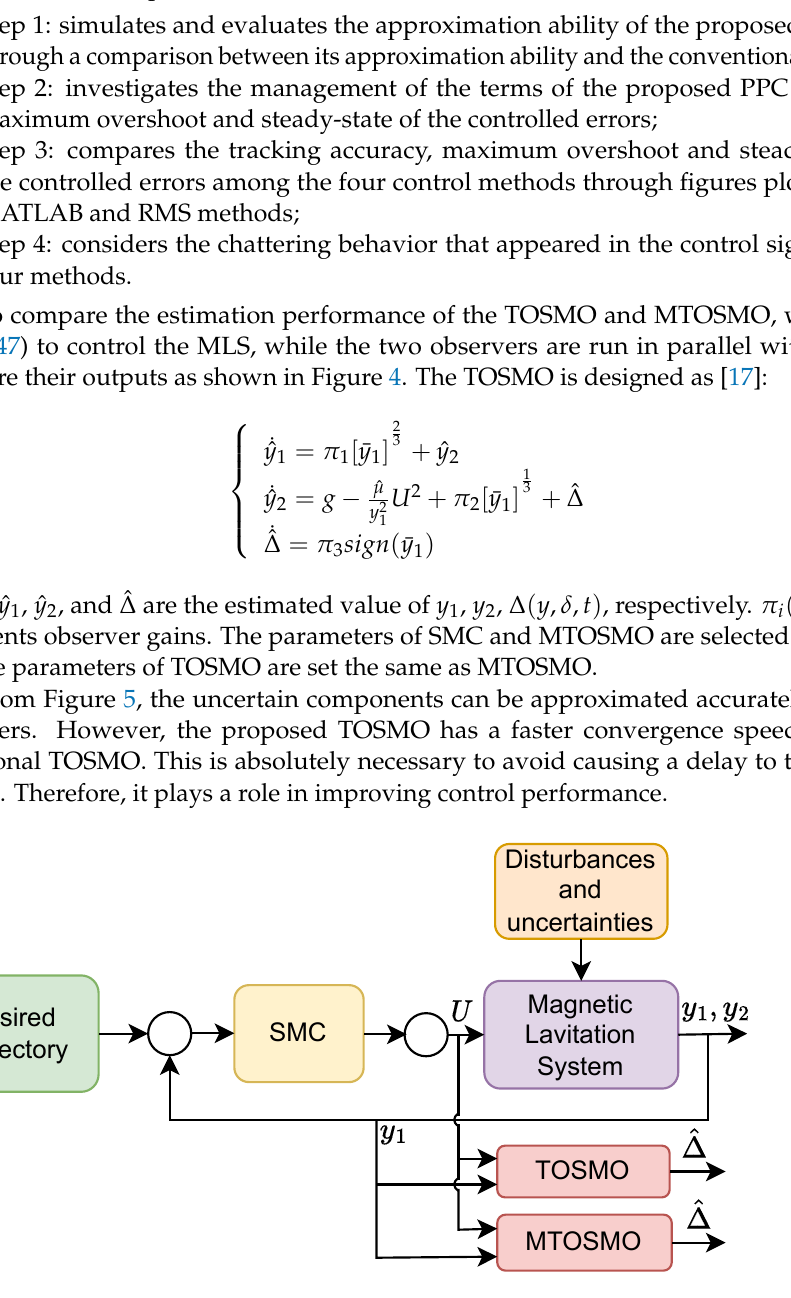
Figure 4. The setting for comparing two